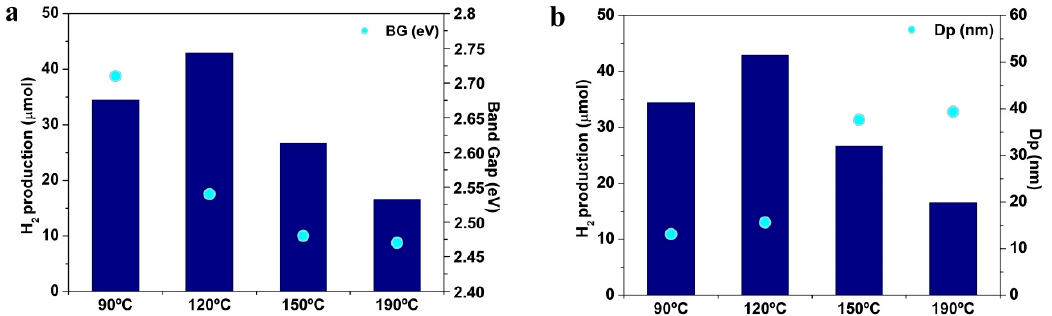
Figure 8. Relationship between photoactivity of AgCdS-T and ( a ) band gap or ( b ) CdS crystallite size.